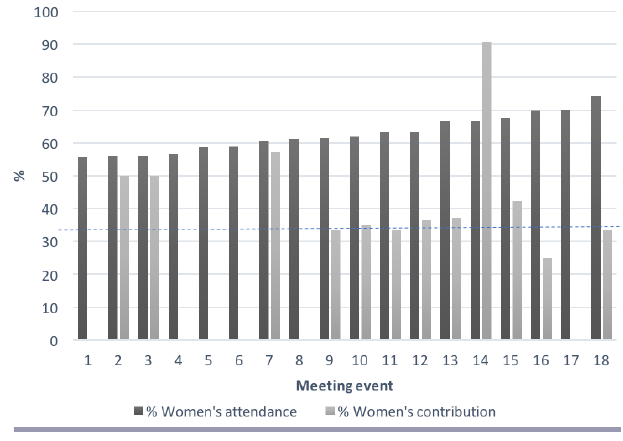
Fig. 3 . Women’s attendance and contribution to meetings.